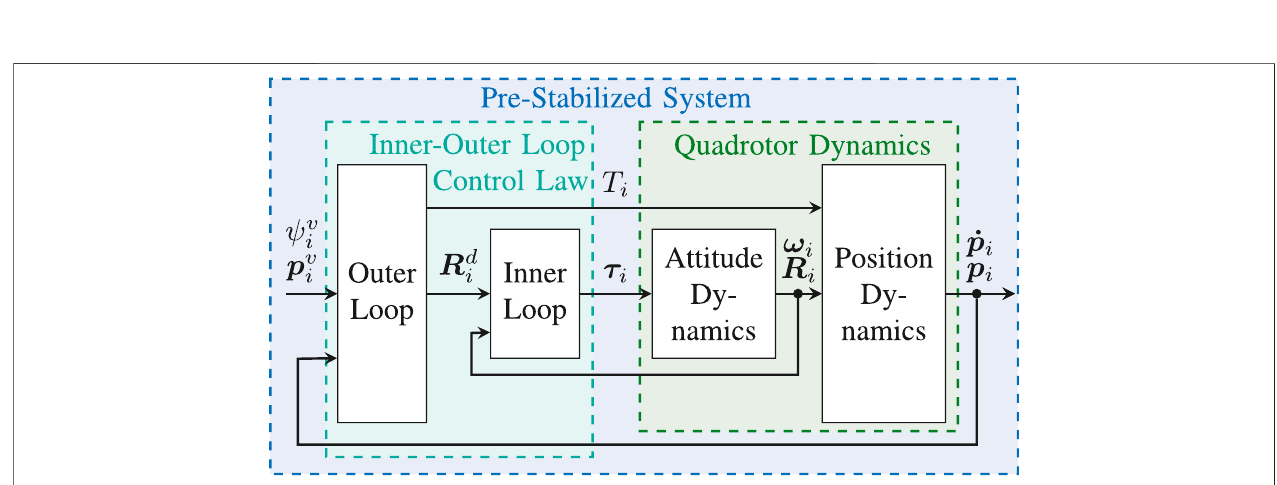
FIGURE3| Pre-Stabilizing ControlScheme − Inthetraditionalinner-outerloopcontrolparadigm,itisassumed thattheinnerloopcontrollawstabilizestheattitude dynamics an order of magnitude faster than the outer loop control law stabilizes the position dynamics.